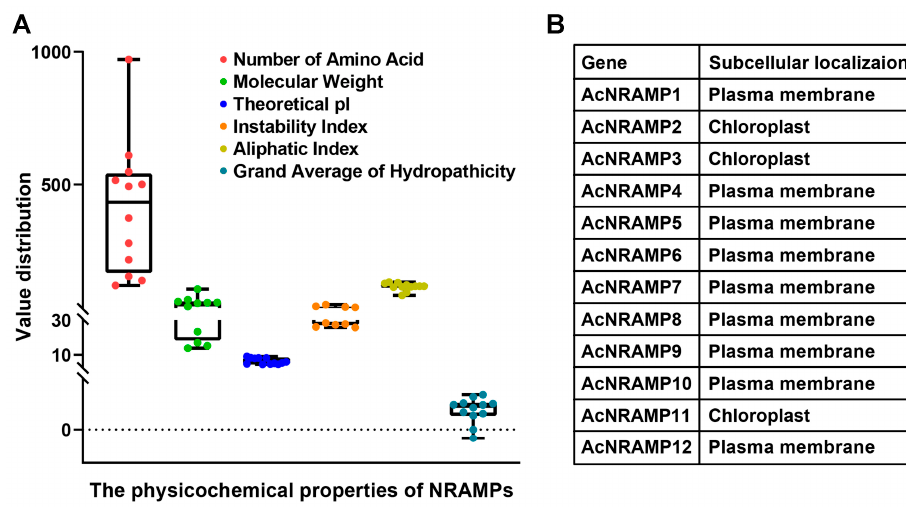
Figure 1. Physicochemical properties of AcNRAMPs ( A ) and prediction of subcellular localization ( B ).